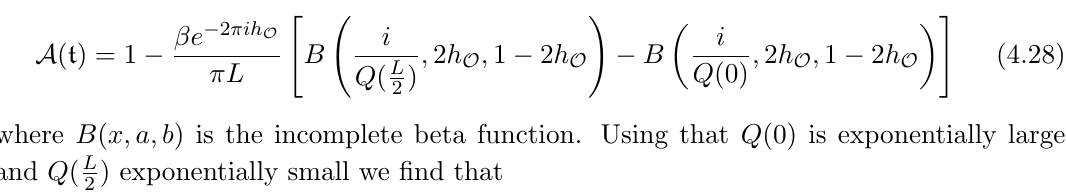
Figure 7 . The sub-scrambling, transition, and stable regions for di(cid:11)erent values of x for (3.34). To (cid:12)nd A for such values of t we note that (4.27) can in fact be exactly integrated,